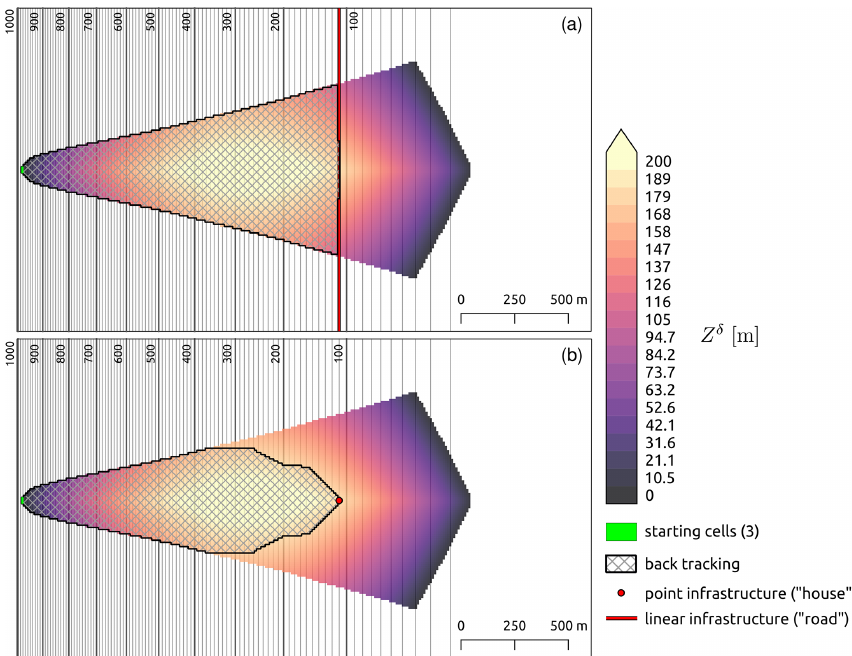
Figure 9. GMF runout modeled with Flow-Py and results of the back-tracking extension with α = 25 ◦ , exp = 8, R stop = 3 × 10 − 4 , and = 8849m. The textured areas highlight starting, transit, or runout zones associated with endangering linear infrastructure (a) or a Z δ lim building (b) . The topography is a simple parabolic slope connected to a flat